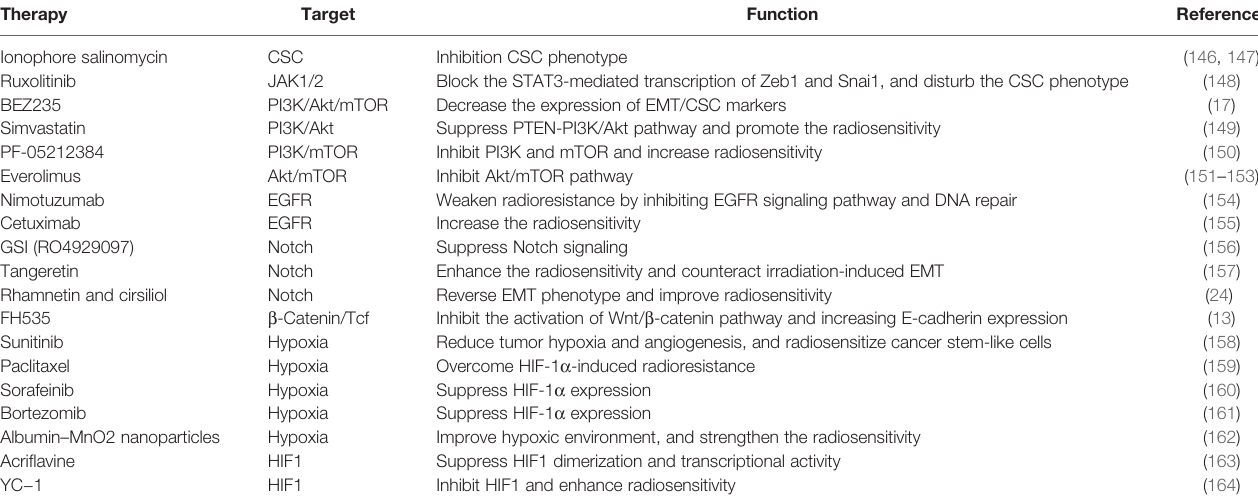
TABLE 2 | Novel strategies targeting EMT-induced radioresistance.